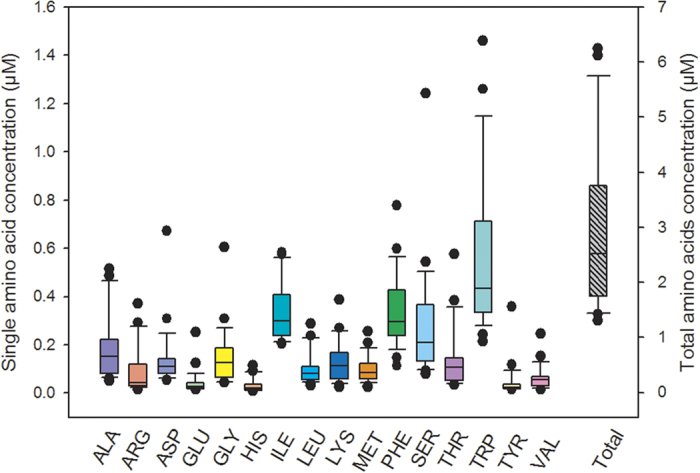
Distribution of each AA in the cloud samples.The bottom and top lines of the box correspond to the 25th and 75th percentiles, respectively. The middle line represents the median. The ends of the whiskers are the 10th and 90th percentiles, and the filled circle is an outlier. The y-right scale shows the total AA concentration.